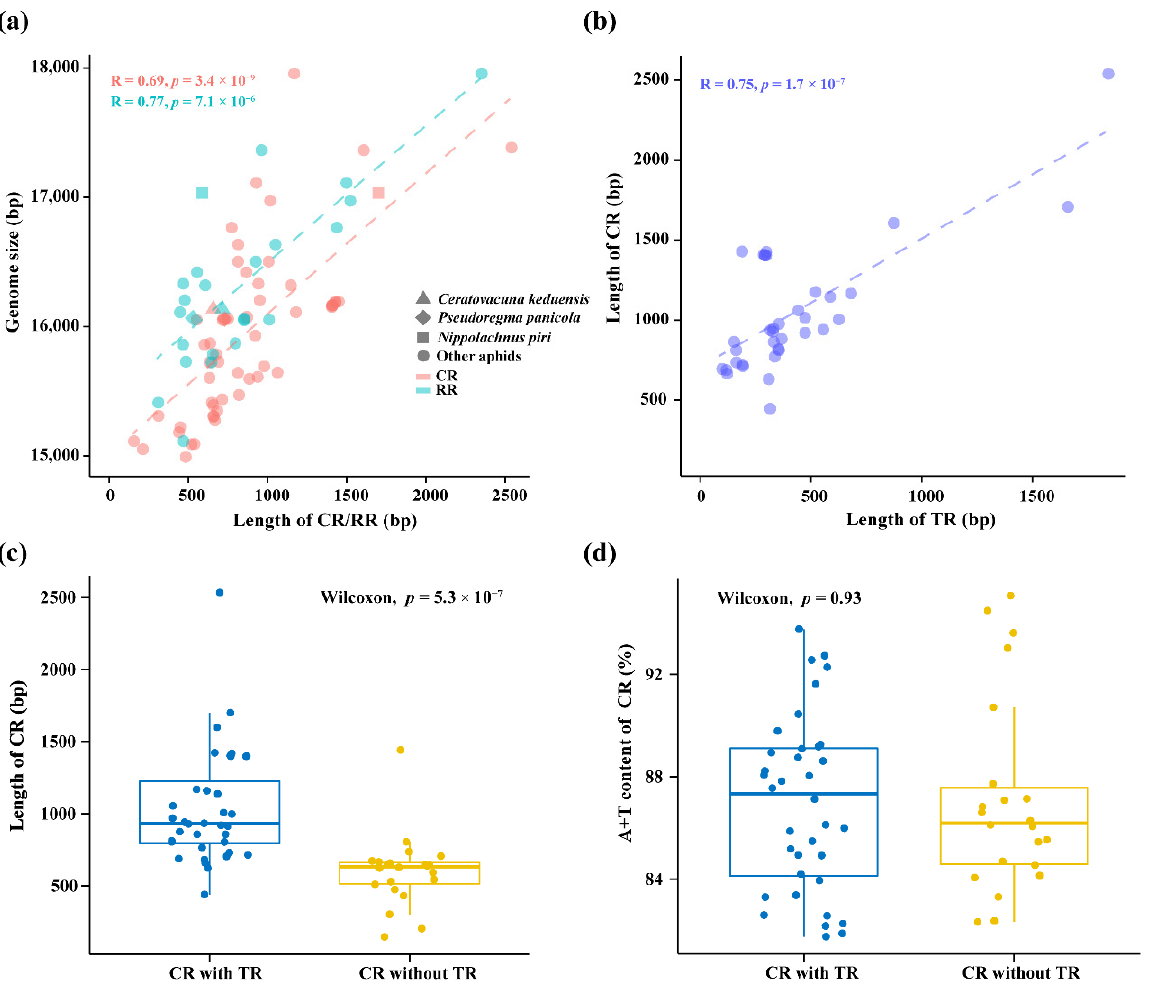
Figure 3. Genomic characteristics of 56 aphid mitogenomes analyzed in this study. ( a ) Correlation between mitogenome size and the length of control region (CR) or repeat region (RR). The correlations were tested using Pearson’s correlation coefficient. The same as bellow; ( b ) correlation between the lengths of control region and inserted tandem repeats (TR); ( c ) the length and ( d ) A + T content of control regions with or without tandem repeats. p < 0.05 denotes statistically significant difference between the two groups (Wilcoxon test).